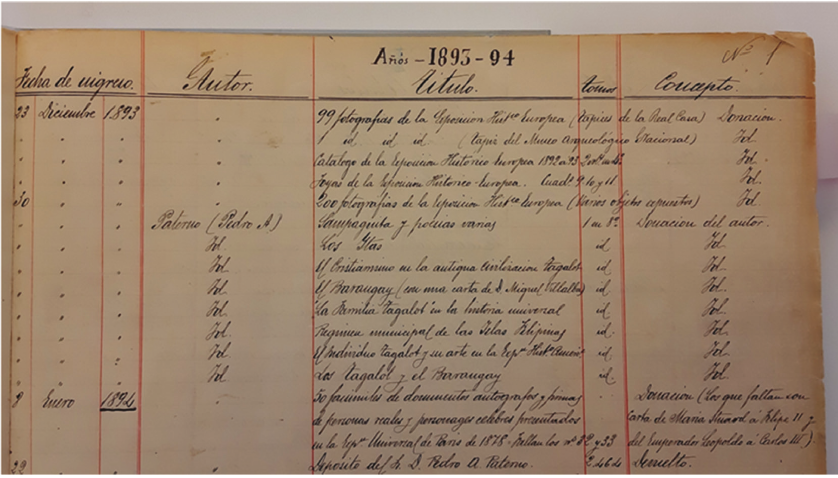
Fig. 2: First Register Book of the Library of the National Archaeological